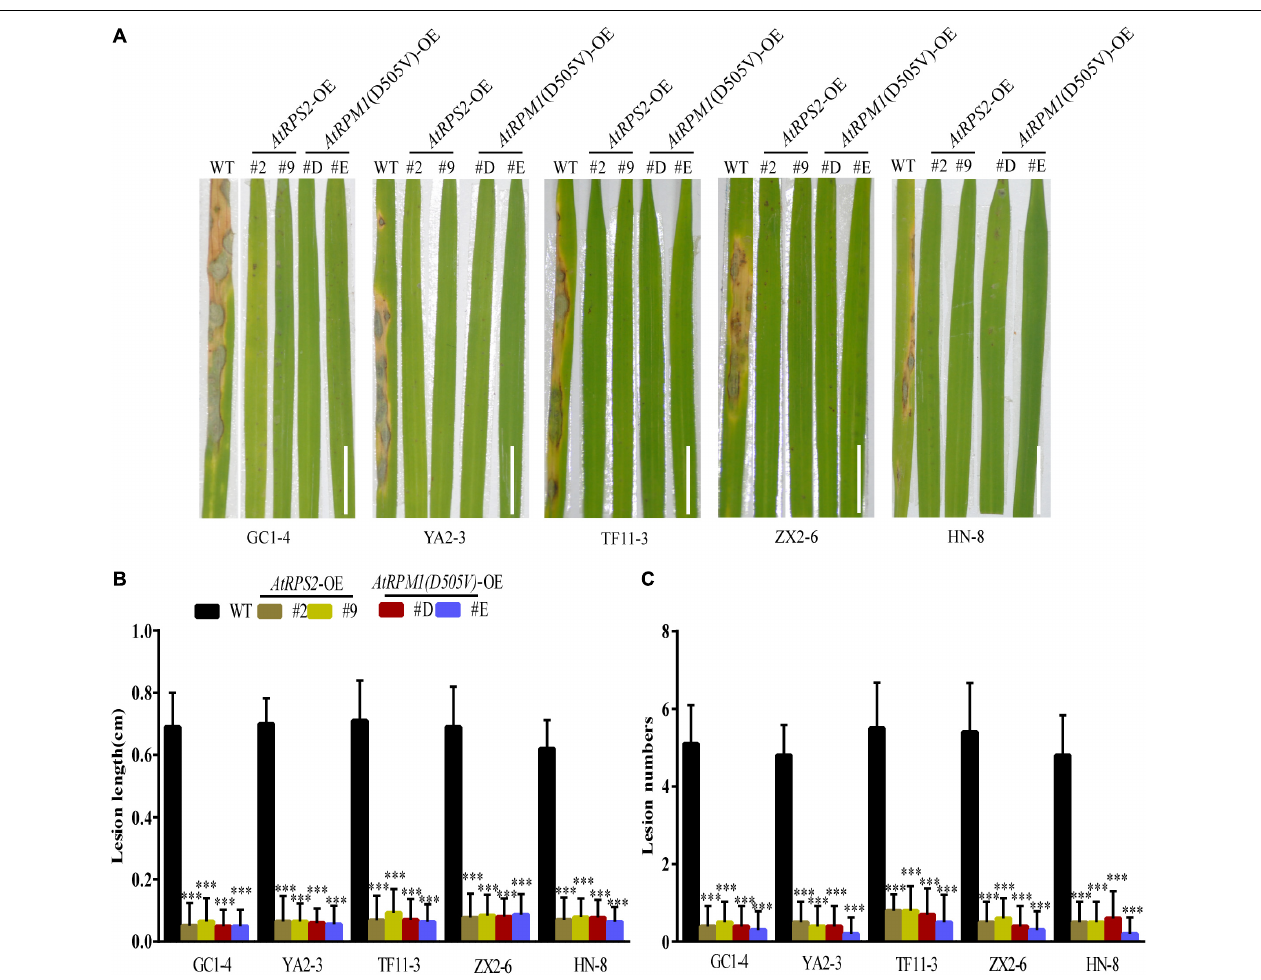
FIGURE 1 | Overexpression of AtRPS2 and AtRPM1 ( D505V ) Confers Resistance Against M. oryzae in Transgenic Rice. (A) Representative disease symptoms on leaves of the AtRPS2 and AtRPM1 ( D505V ) transgenic plants and Nipponbare. Four-week-old plants were inoculated with different isolates of M. oryzae , and pictures were taken at 7 dpi. Scale bars = 2 cm. (B,C) Average lesion length and lesion numbers of AtRPS2 , AtRPM1 ( D505V ) transgenic plants and Nipponbare at 7 dpi inoculated with M. oryzae isolates. Data are shown as means ± SD ( n = 20). Asterisks represent significant differences (one way ANOVA, ∗∗∗ P < 0.001). Similar results were obtained in three independent